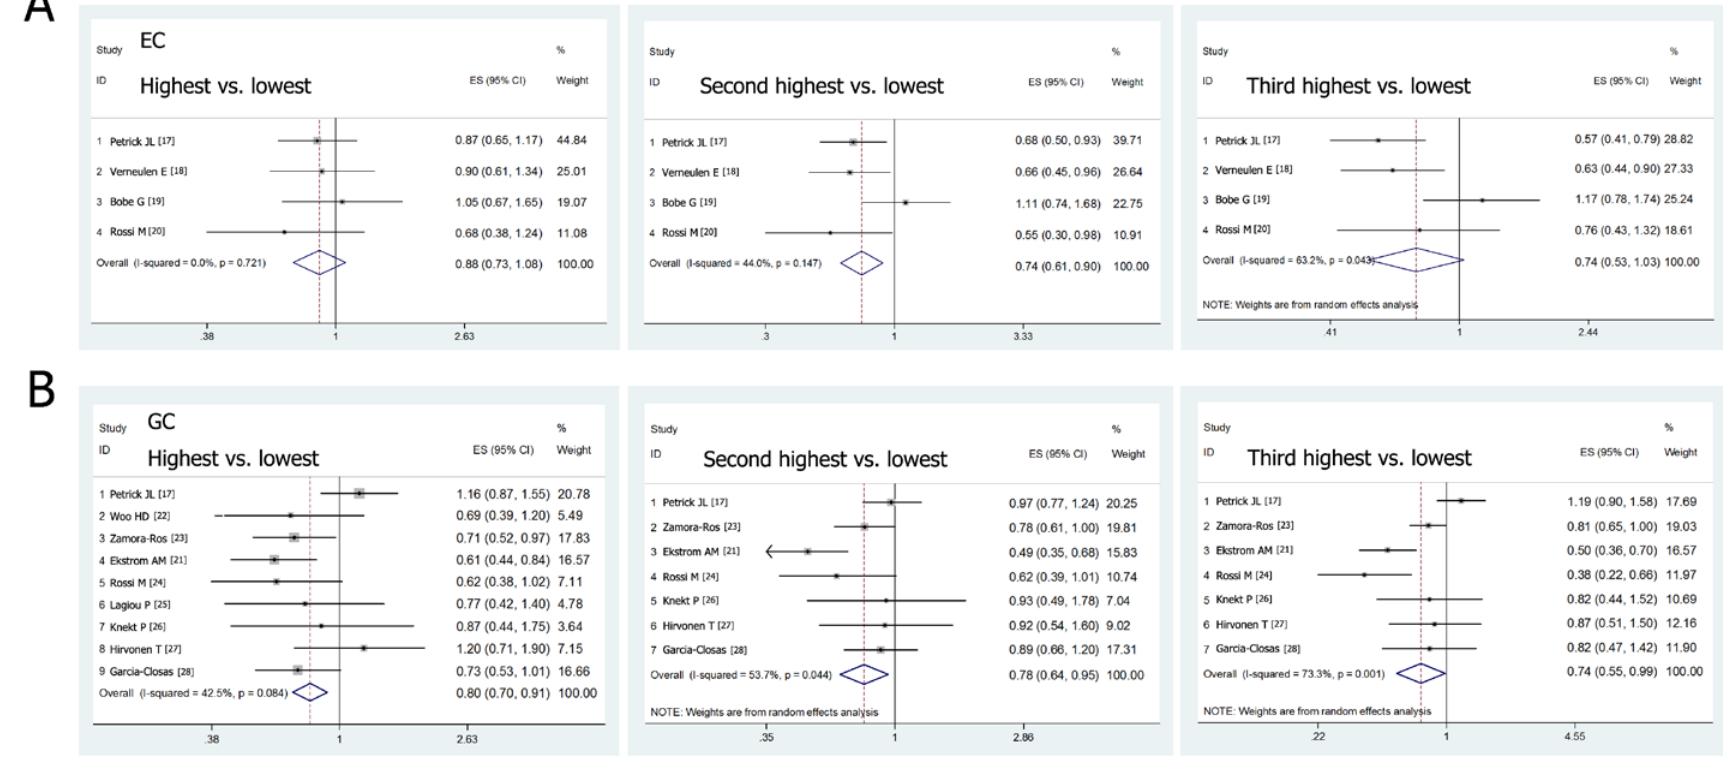
Figure 2. Forest plots investigating the association of dietary flavonol intake and the risk of esophageal cancer (EC) and gastric cancer (GC).